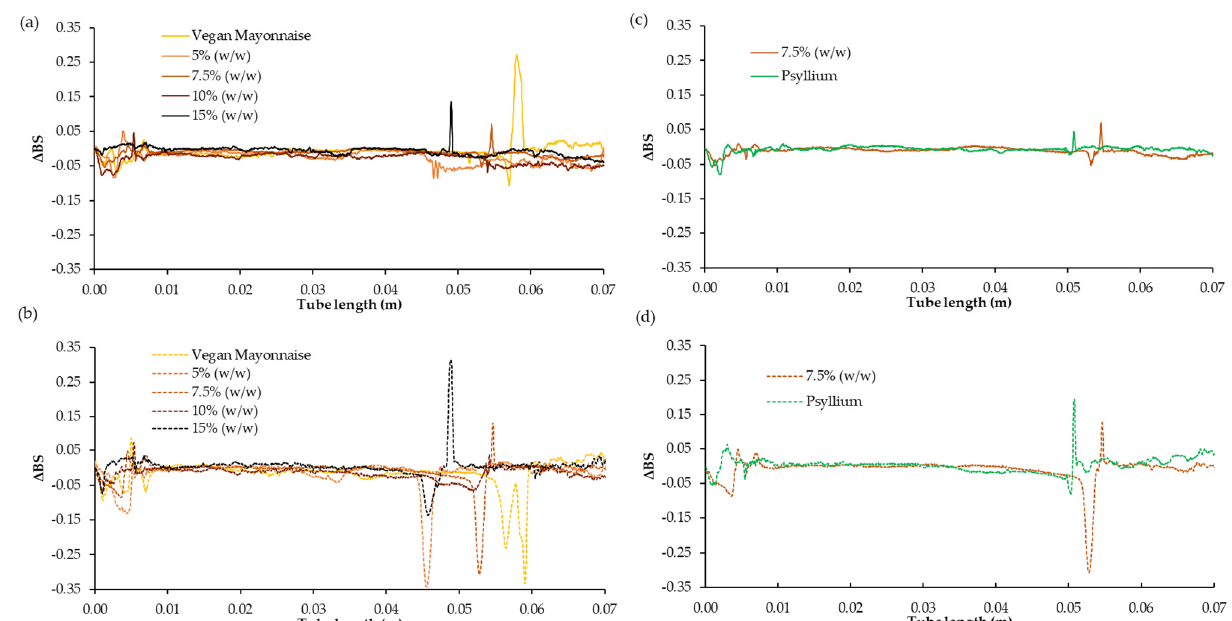
Figure 16. Changes in backscattering profiles ( ∆ BS) as a function of sample height of emulsions with 5, 7.5, 10 and 15% ( w / w ) of miso paste and standard emulsion, measured 1 day ( a ) and 30 days ( b ) after emulsion preparation. ∆ BS profiles for 7.5% ( w / w ) of miso paste, one of them with 0.1% ( w / w ) of psyllium husk, measured 1 day ( c ) and 30 days ( d ) after emulsion preparation are also shown.